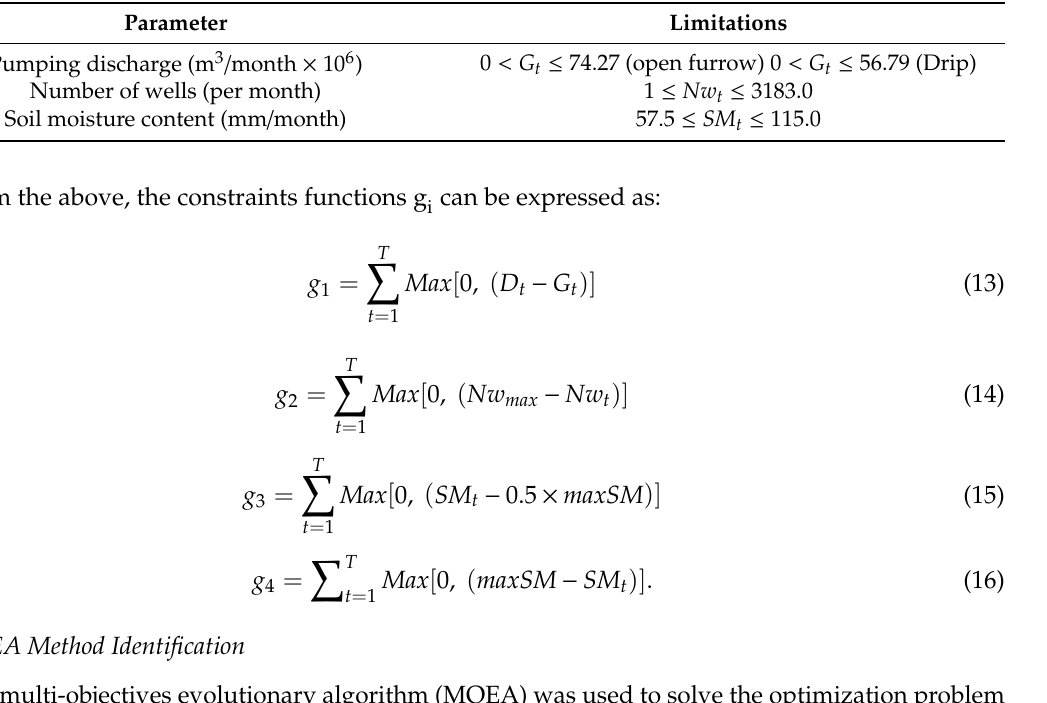
Table 3. Groundwater management constraints in the central part of Diyala river